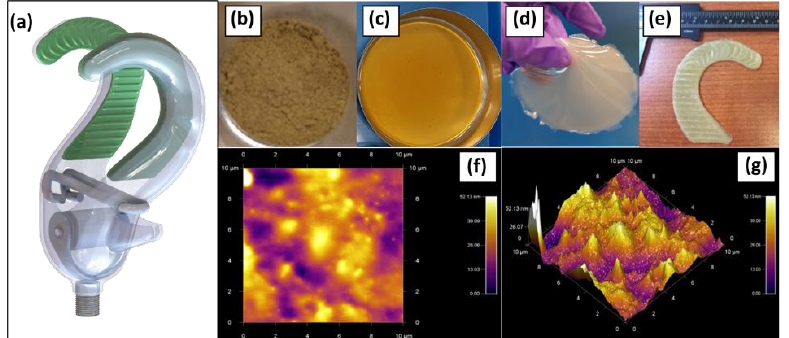
13 of 18 Figure 11. Surface properties of chemically treated carbon fiber: ( a ) carbon fiber material (blue) covered with hydrophobic polyester resin; ( b ) water repellence observed by depositing droplets on the surface; ( c ) characteristic image of a droplet with contact angles marked; ( d , e ) AFM images (2D and 3D representations, respectively) of the treated carbon fiber, showing details of surface relief and roughness. Silicone is a widely used material for the handling of food products because it is to- tally inert and resists extreme temperatures. In addition, its non-slip properties caused by a high coefficient of friction provides an excellent grip. Therefore, silicone was selected as the material for the inner surfaces (Figure 12a), since this area of the Carbon HK VO hook is in contact with different objects, including food products. At this stage, a lab-scale pro- totype, Dragon Skin 30 silicone rubber, was used. This commercial silicone was enriched